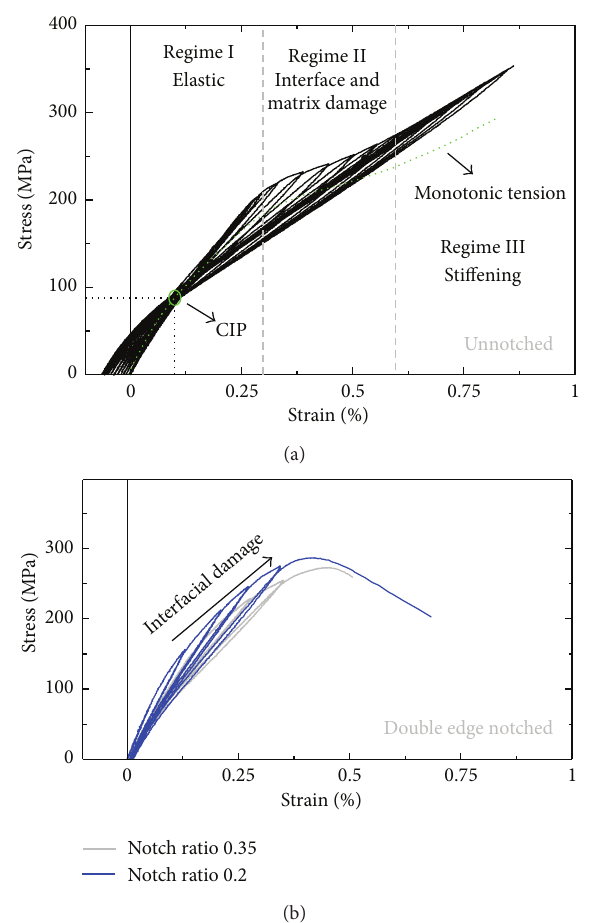
Figure 3: Stress-strain response of SiC/BMAS under monotonic loading (dotted line in (a)) and cyclic tension with unload- ing/reloading loops for (a) un-notched specimens and (b) notched specimens with various notch